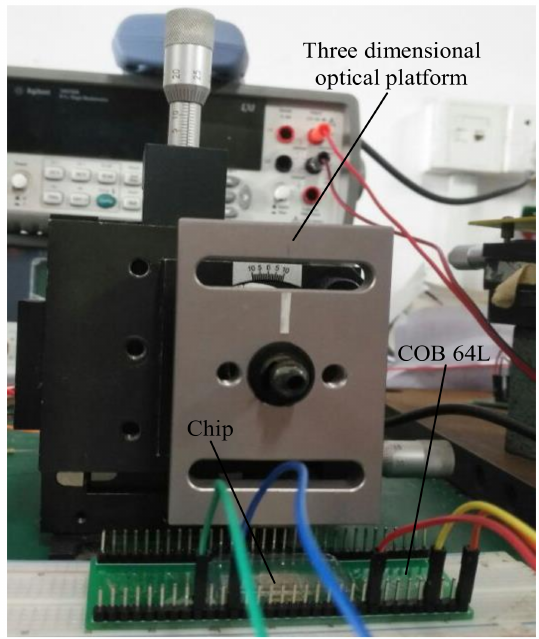
Figure 12. Photo of the experimental